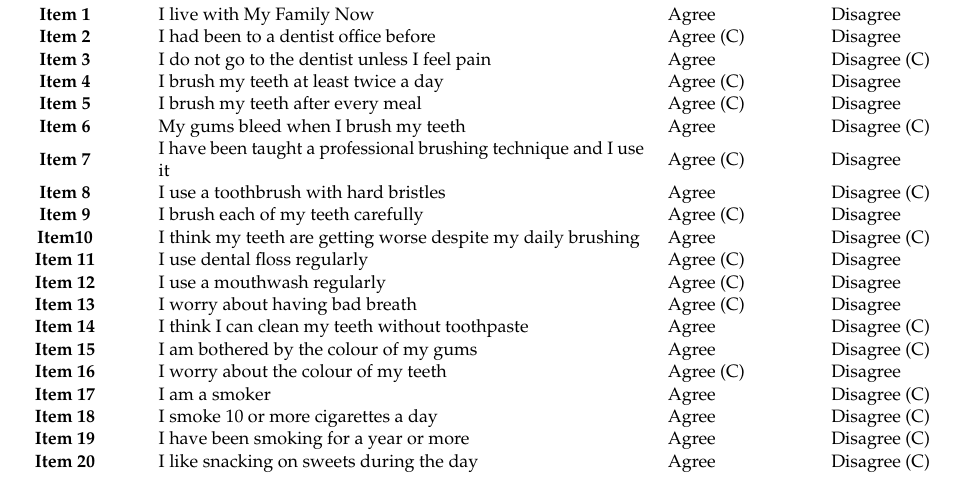
Table 1. The modified English version of the Hiroshima University-Dental Behaviour Inventory (HU-DBI) survey in this study. Answers favouring correct oral health attitudes and behaviour were marked with (C).